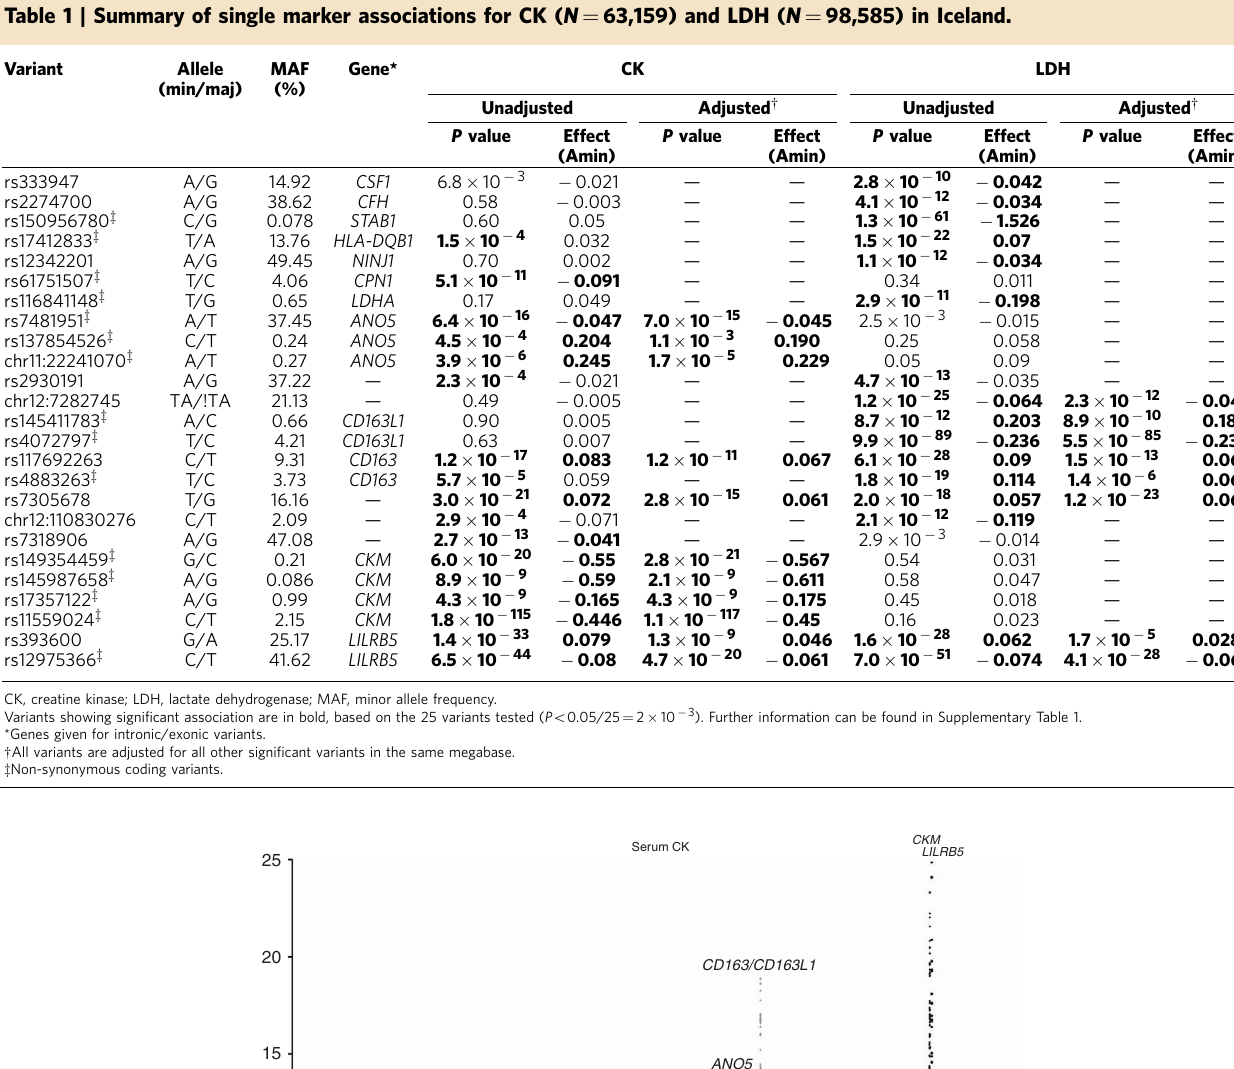
(Table 1). We observed no correlated coding variants ( r 2 4 0.6)